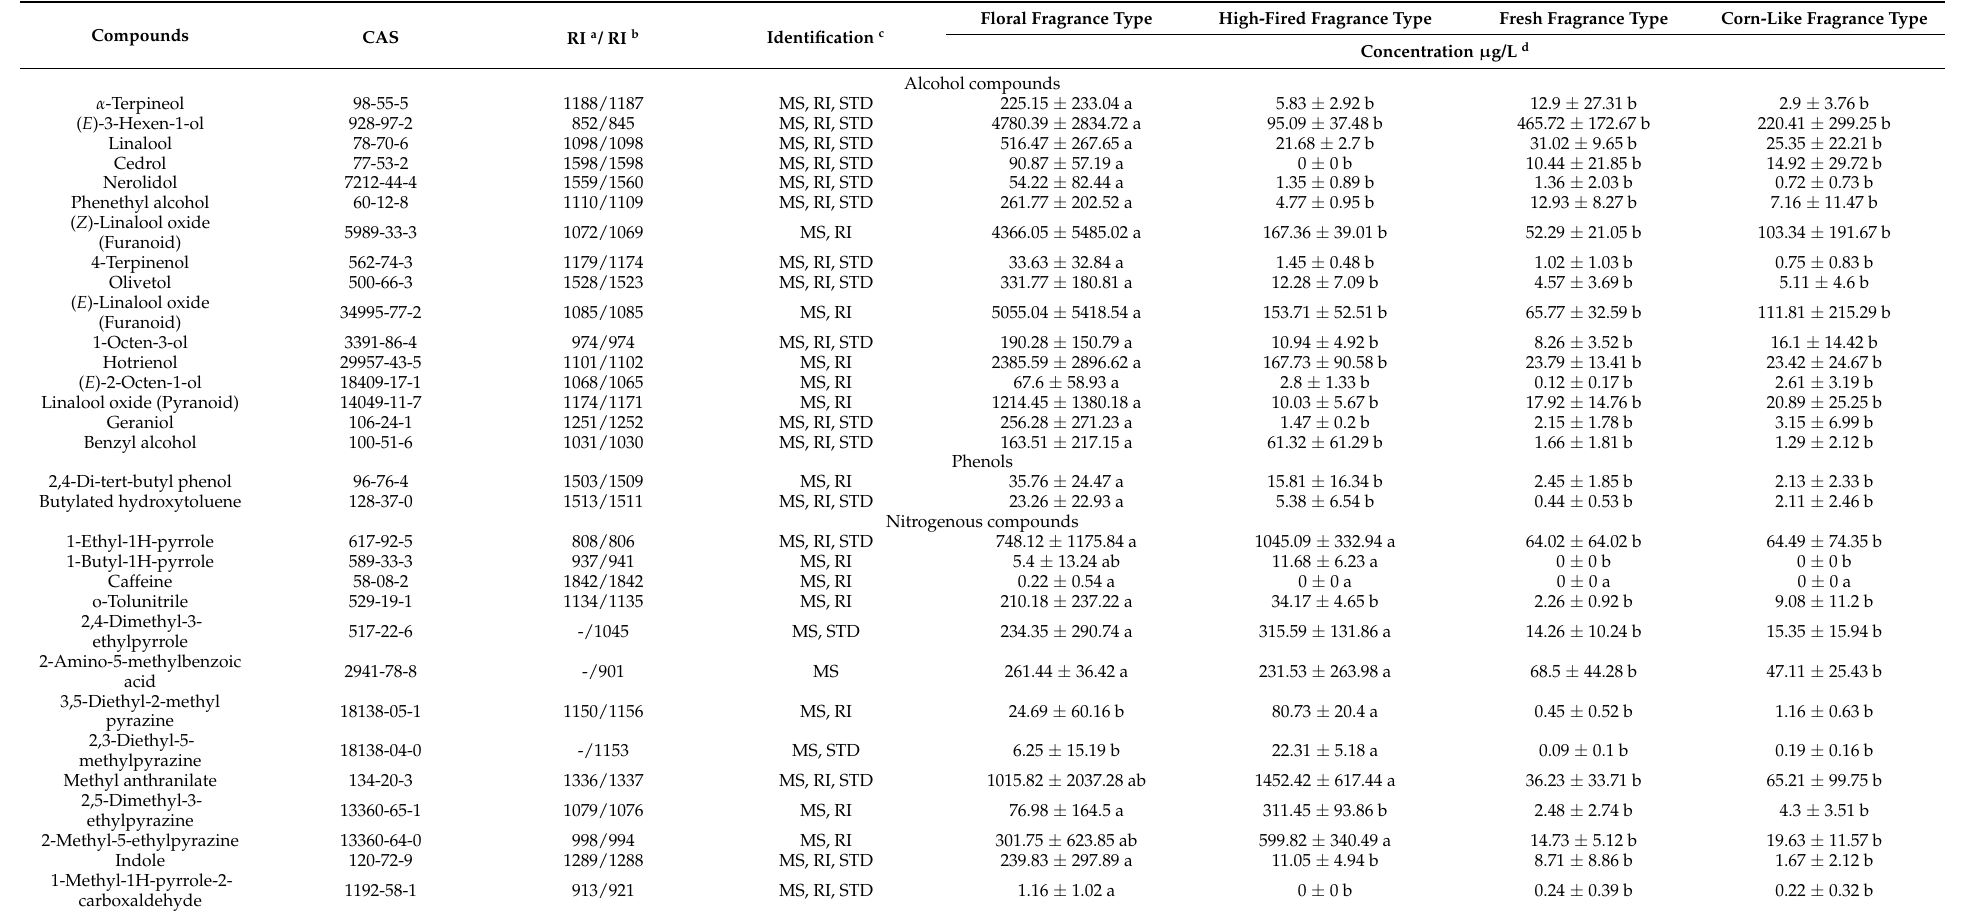
Table 1. Identification of the volatiles in different aroma types of yellow